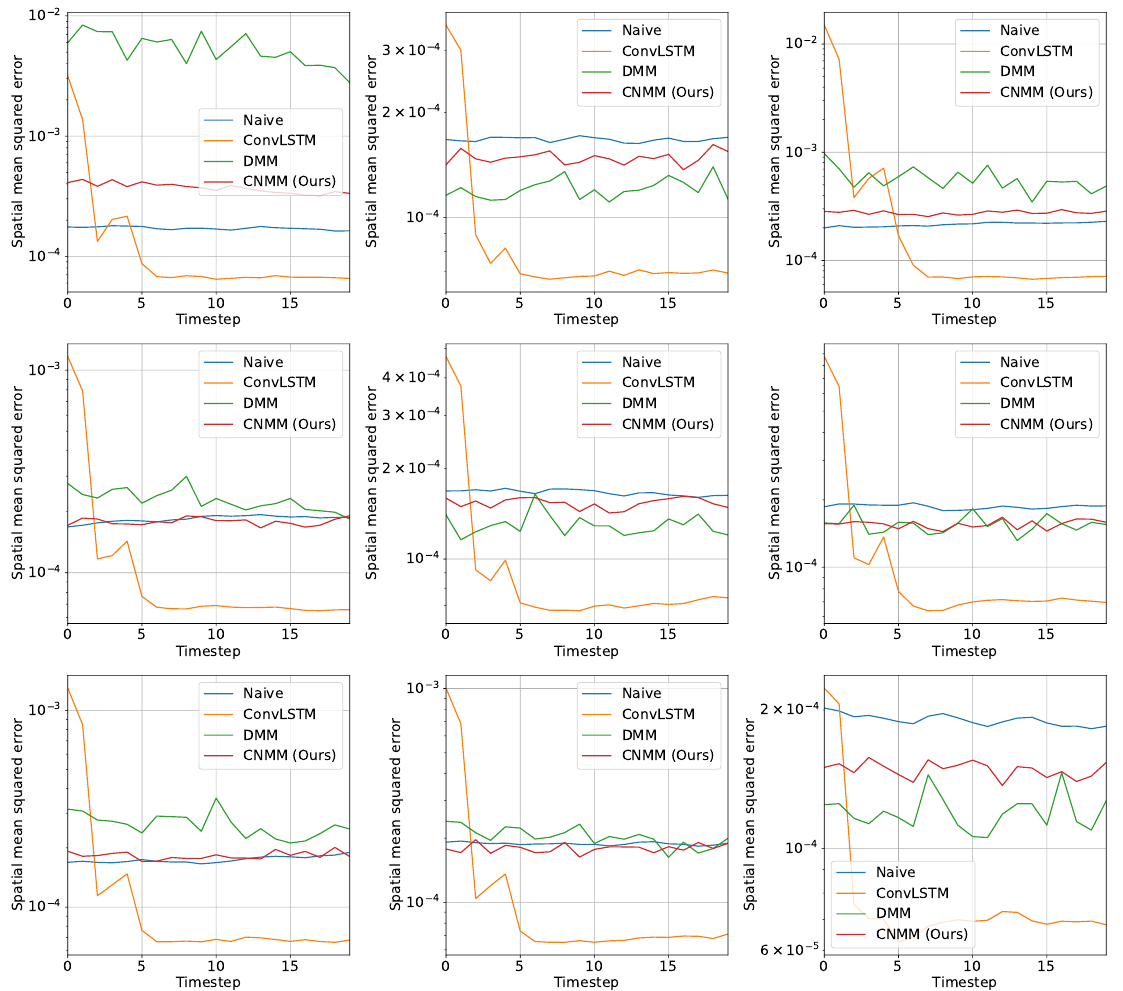
Figure 6. Spatially averaged (spatial mean) squared forecast error of baseline and our models on nine randomly selected 2D heat equation validation data. The data used here is from the Emission 1 condition, and the length of the forecast is 20. The y-axis shows the error value, and the x-axis shows the timestep of the forecast. It is clear that ConvLSTM’s forecasts underperformed on the first initial steps, while other models are more stable at forecasting the dynamics of the